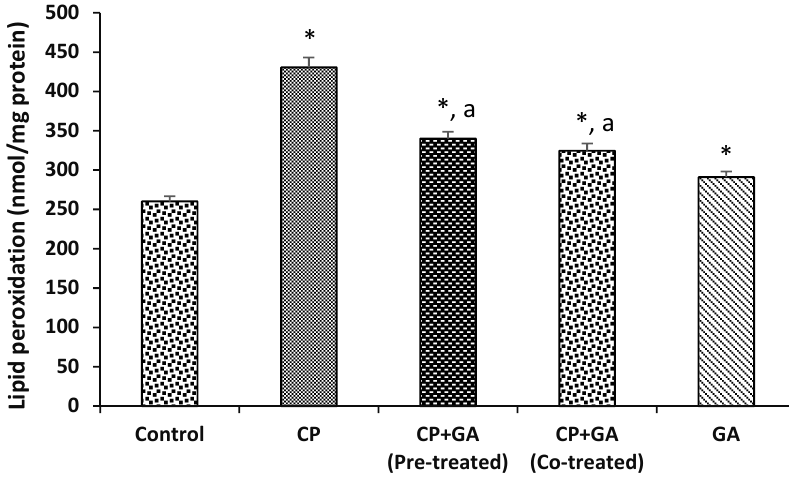
Figure 5. Protective effects of gallic acid on cyclophosphamide induced changes in the levels of hepatic Lipid peroxidation in rats. CP = cyclophosphamide (2 mg/kg body weight); GA = gallic acid (20 mg/kg body weight); Data are expressed as mean ±SD for five rats in each group; * Significantly different from the control ( p < 0.05); a Significantly different from cyclophosphamide